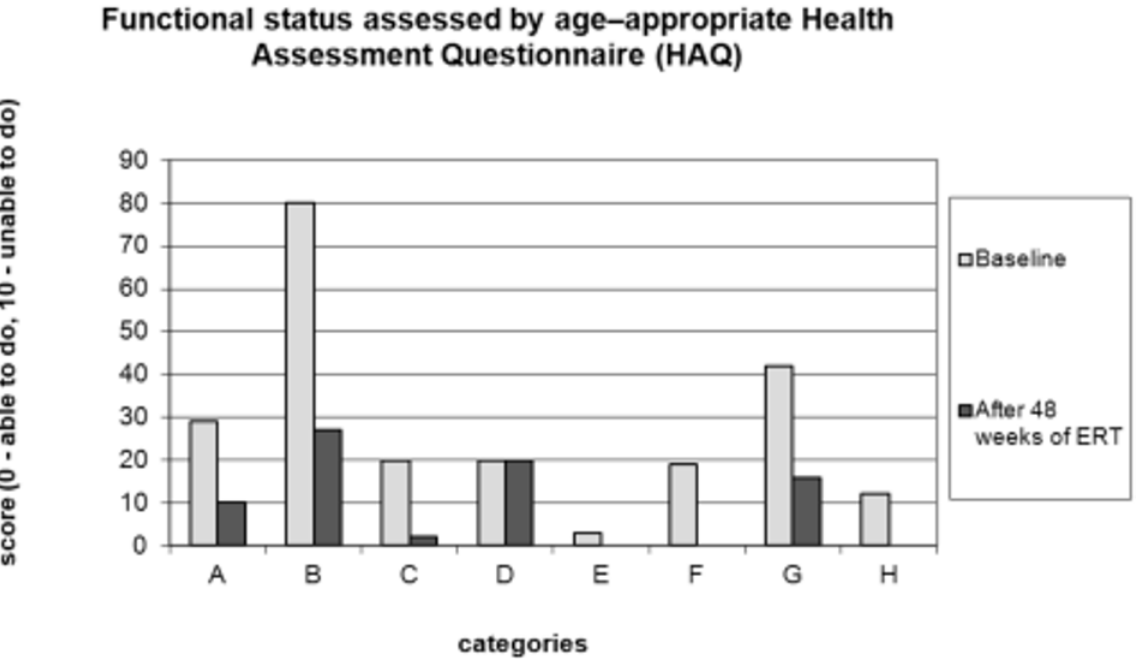
Figure 8. Functional status of the patient assessed by age-appropriate HAQ at baseline and after 48 weeks of ERT. Categories assessed by HAQ: A: eating/drinking; B: dressing; C: bathing; D: grooming; E: tooth brushing; F: toileting; G: mobility; H: walking and stair